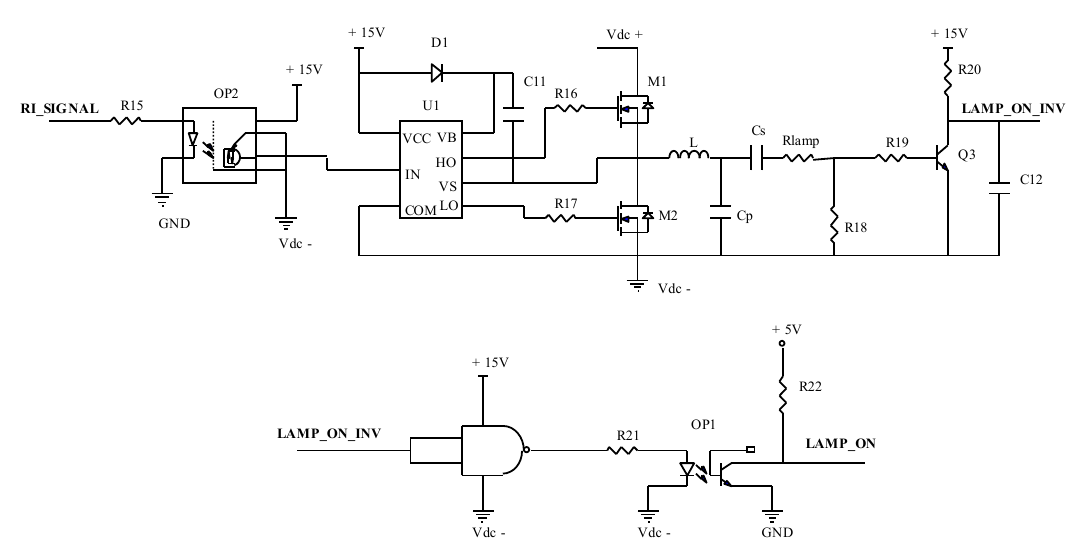
Figure 10. Management of ballast operating modes from the PIC18F2220 microcontroller. The deviation of the resonance frequency due to the magnetization inductances of the lamp is shown in the simulation of the lighting of the lamp in Figure 11.